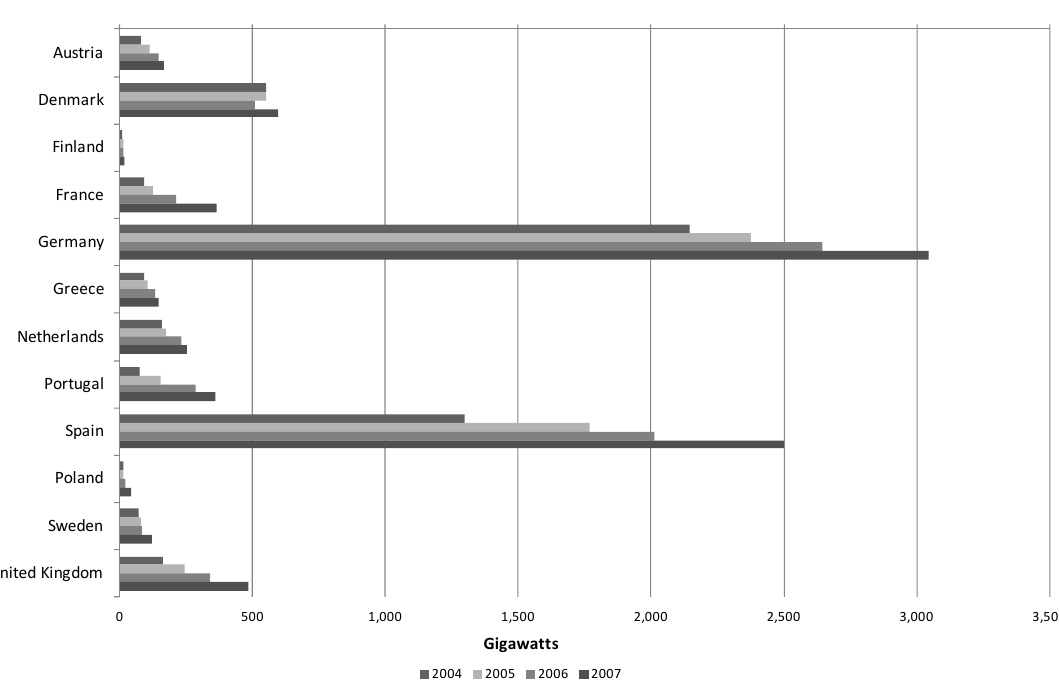
Figure 3. Renewable electricity generation,